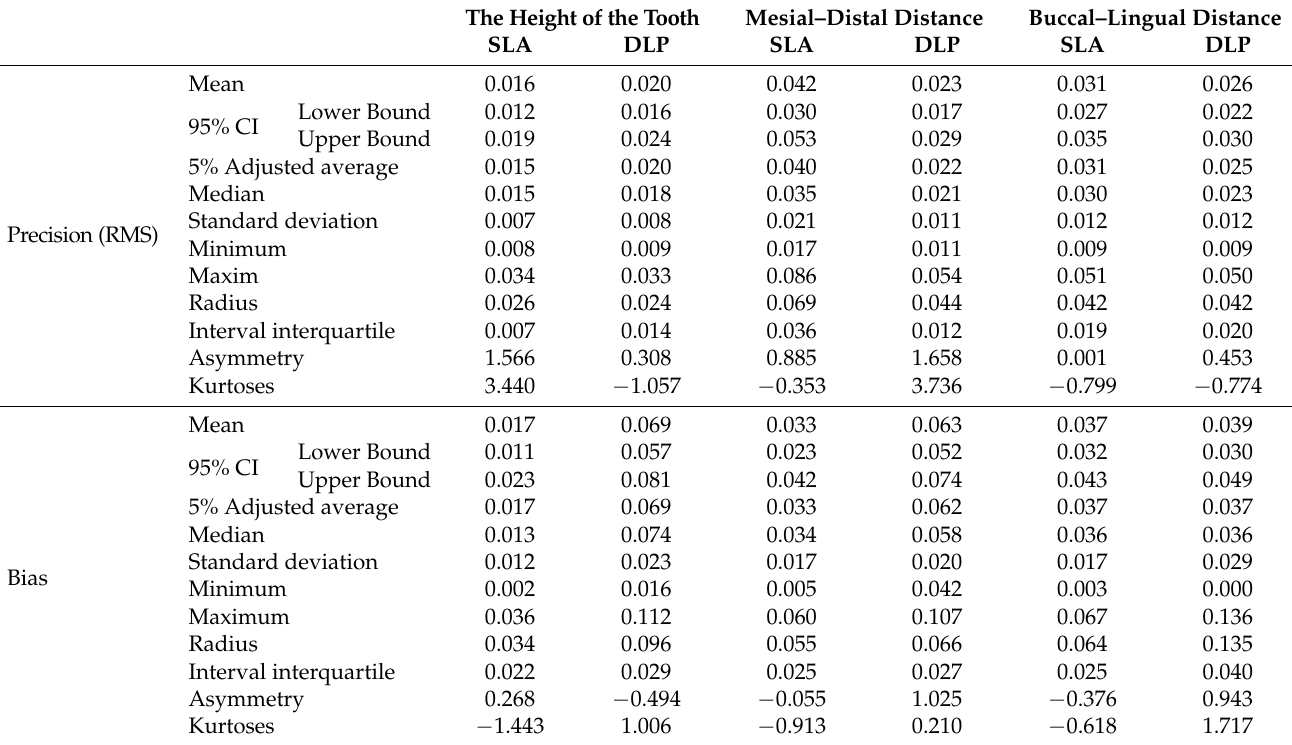
Table 1. Descriptive analysis for precision and bias in the study